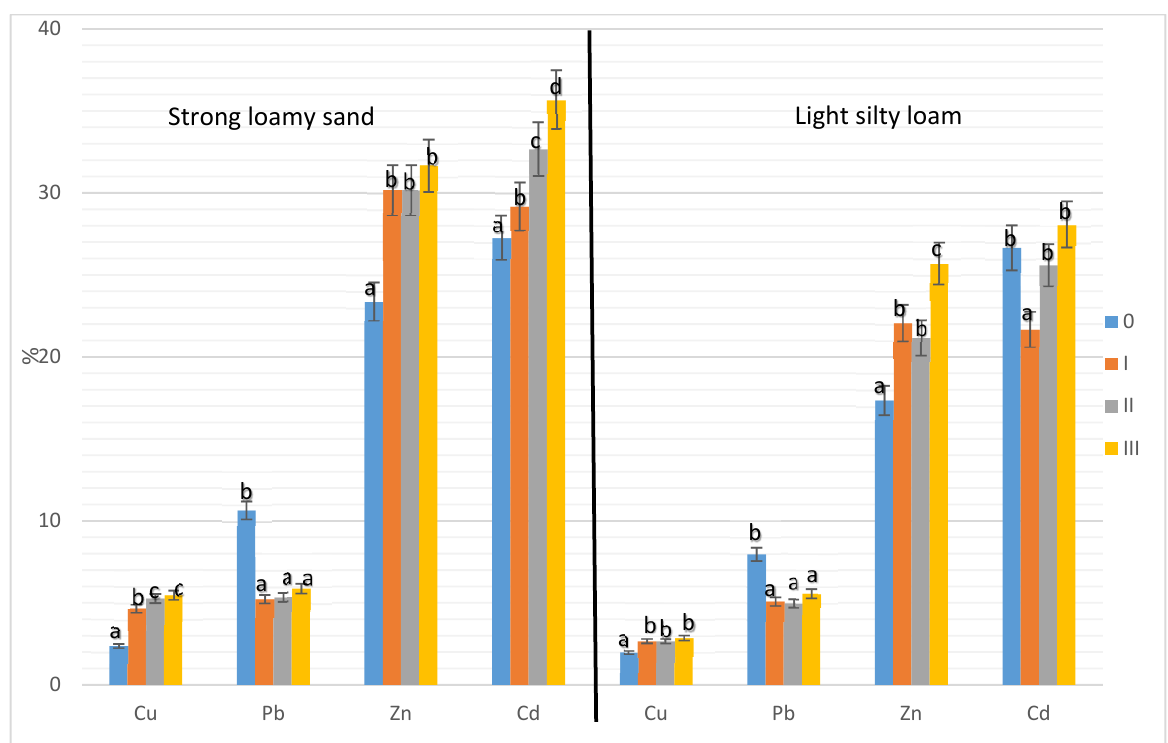
Figure 3. The share of heavy metals determined in 1 M NH 4 NO 3 (%) in the total amount of these elements determined in royal water according to the level of soil contamination. a, b, c, d—treatments with the same letter are not significantly different ( p ≤ 0.05).